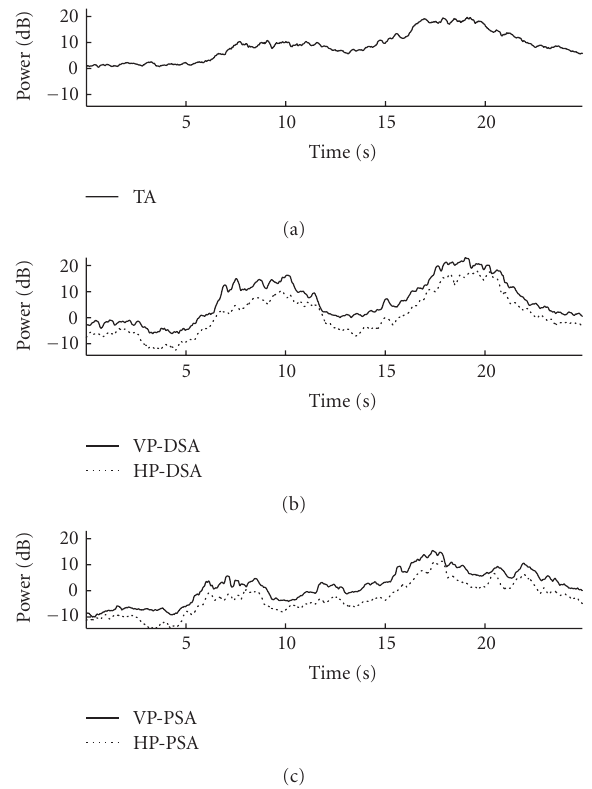
Figure 9: Received power measured at each array along Kent Street.